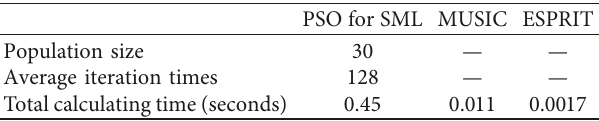
Table 1: Comparison of computational complexity of ESPRIT, MUSIC, and PSO applied for SML for one time DOA